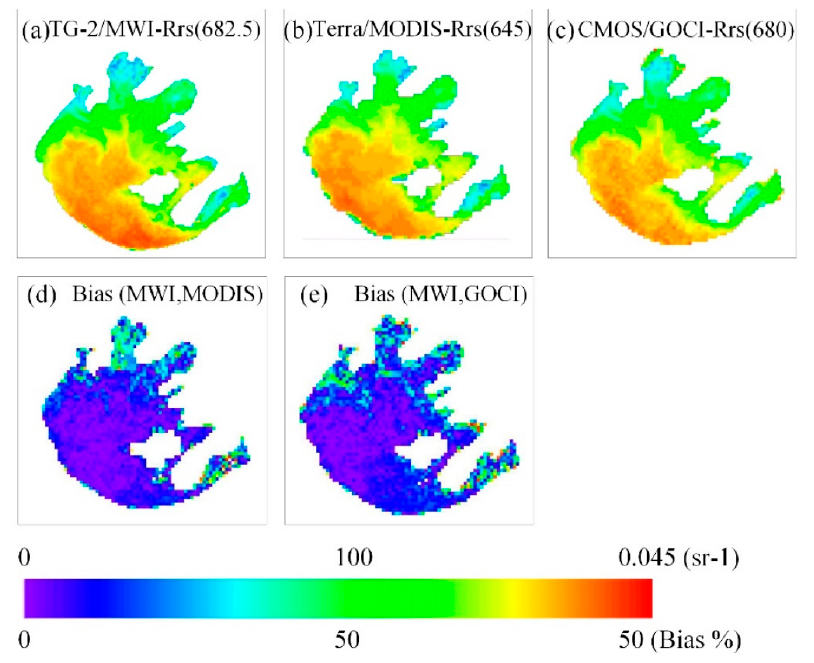
Figure 8 . Maps of the remote sensing reflectance (Rrs) products derived from ( a ) TG ‐ 2/MWI, ( b ) Terra/MODIS and ( c ) CMOS/GOCI data on 14 March 2017. Biases of Rrs derived from ( d ) TG ‐ 2/MWI and Terra/MODIS (Bias(MWI, MODIS)), and ( e ) TG ‐ 2/MWI and CMOS/GOCI (Bias(MWI,GOCI)) are displayed in the second row.